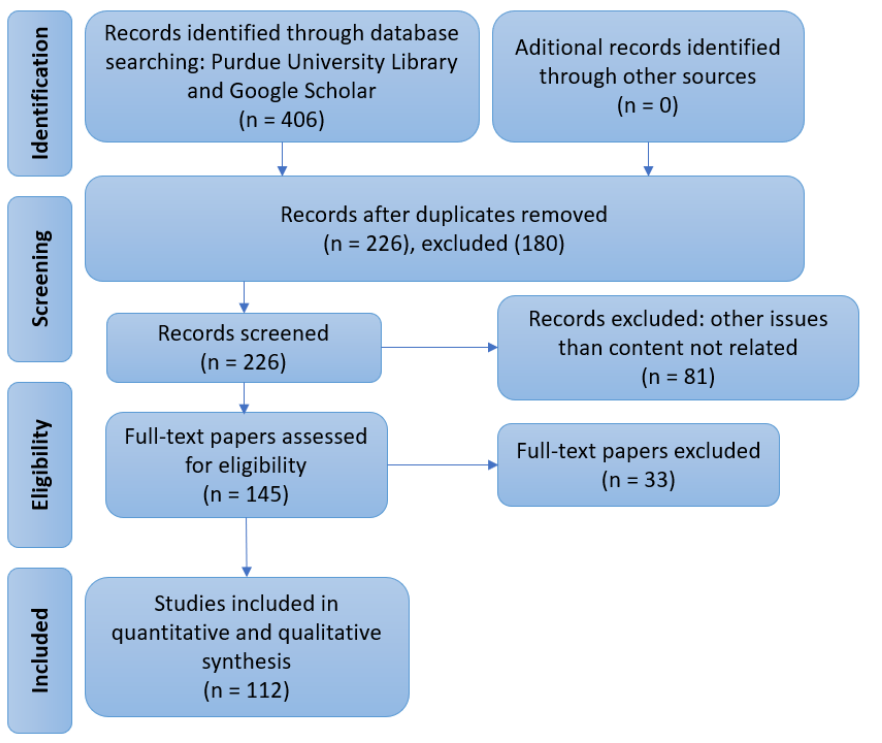
Figure 1. Paper selection